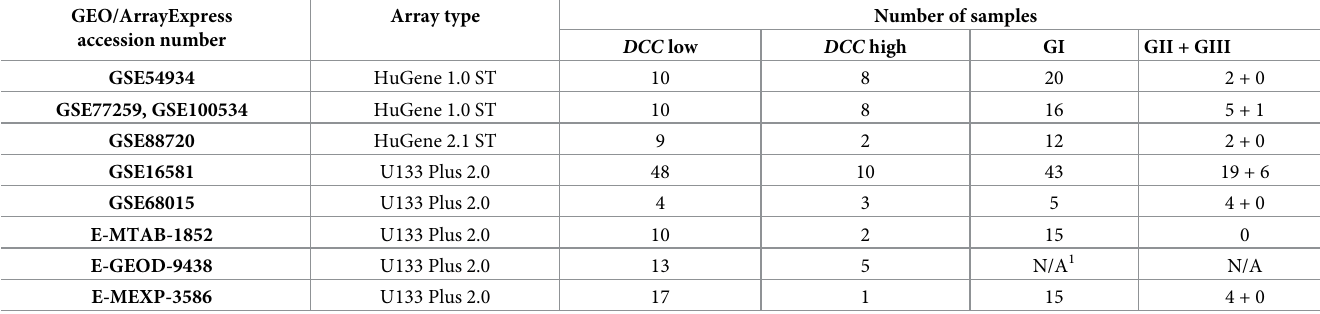
Table 1. Selected array expression studies for meta-analysis on CSC genes in meningiomas. GEO/ArrayExpress accession